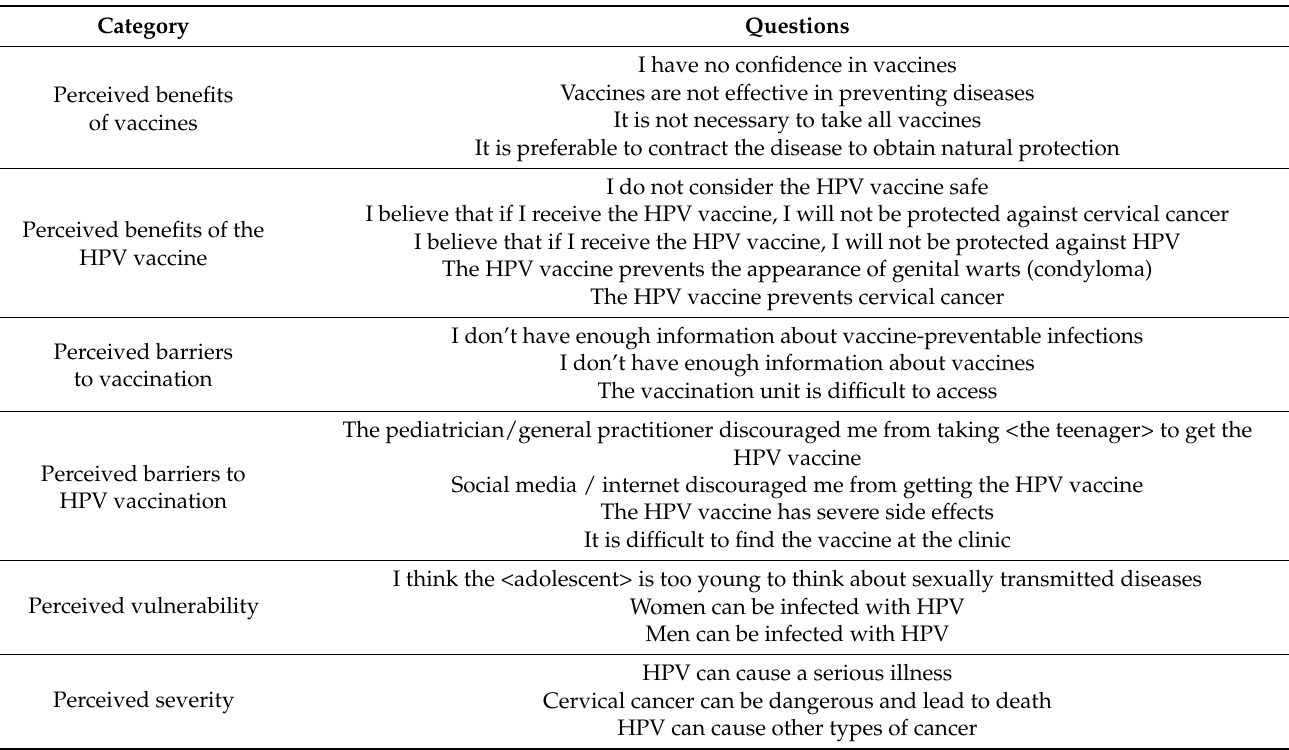
Table 1. Categories and questions in the Health Belief